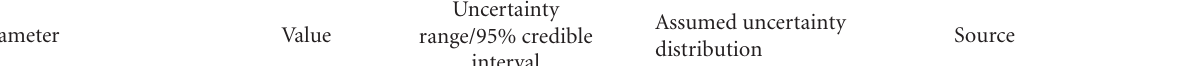
Table 3: Parameters (and distributions) for cost-e ff ectiveness